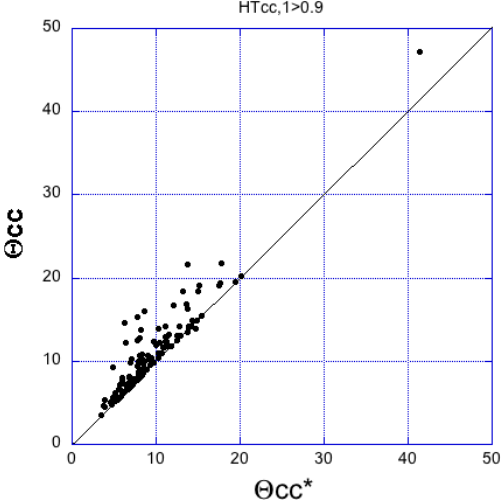
Fig. A1. Scatterplot of the angles 2 cc and 2 ∗ cc , based on the Wal´en correlation coefficients with and without the averages subtracted, respectively, for all 188